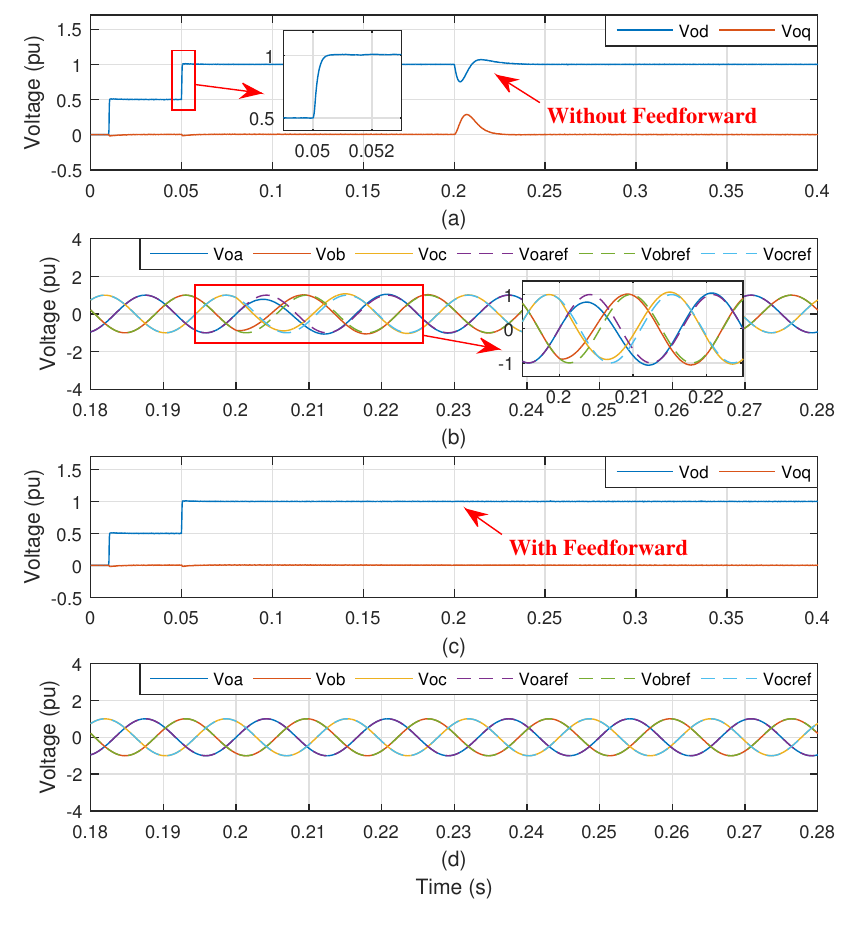
Figure 10. AC-AC 3 × 3 DMC operation with PI 1 ( s ) . ( a ) Output voltage in the dq reference frame without feedforward, ( b ) output voltage without feedforward, ( c ) output voltage in the dq reference frame with feedforward, and ( d ) output voltage with